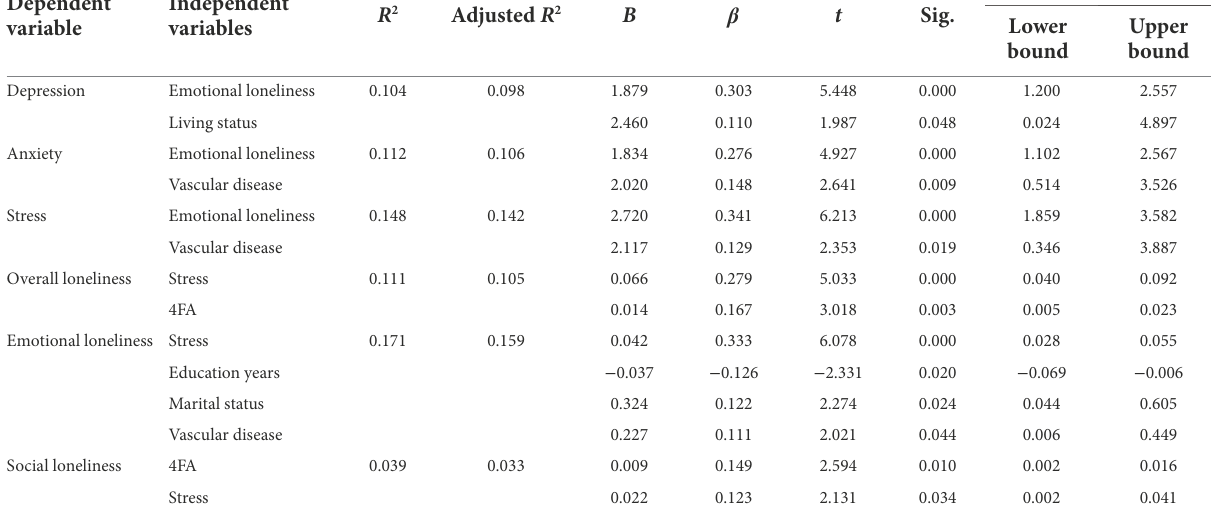
TABLE 2 Multiple stepwise regression between mental health/loneliness scores and other